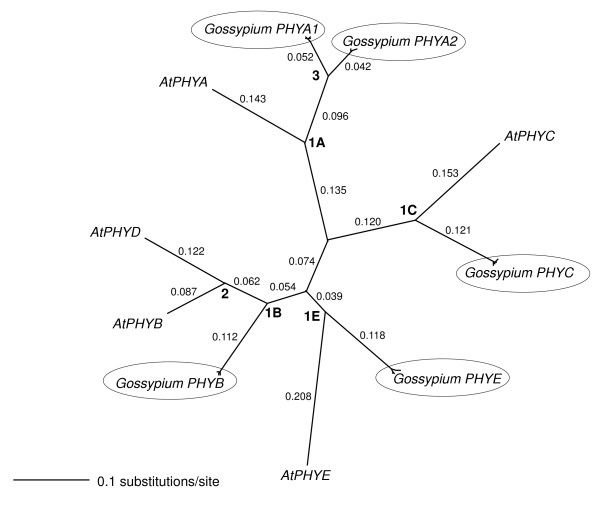
Unrooted NJ tree of phytochrome genes of A. thaliana and cottons (Gossypium spp.) based on a 358 bp consensus alignment of amplification products from the hinge regions. Kimura two-parameter distances are shown for each branch. All internal branches had 100% bootstrap support (500 replicates). 1A, 1B, 1C and 1E denote gene divergence events likely resulting from speciation. 2 and 3 denote gene divergence events likely resulting from gene duplication. All Gossypium phytochrome genes are included within clusters (indicated by ovals).